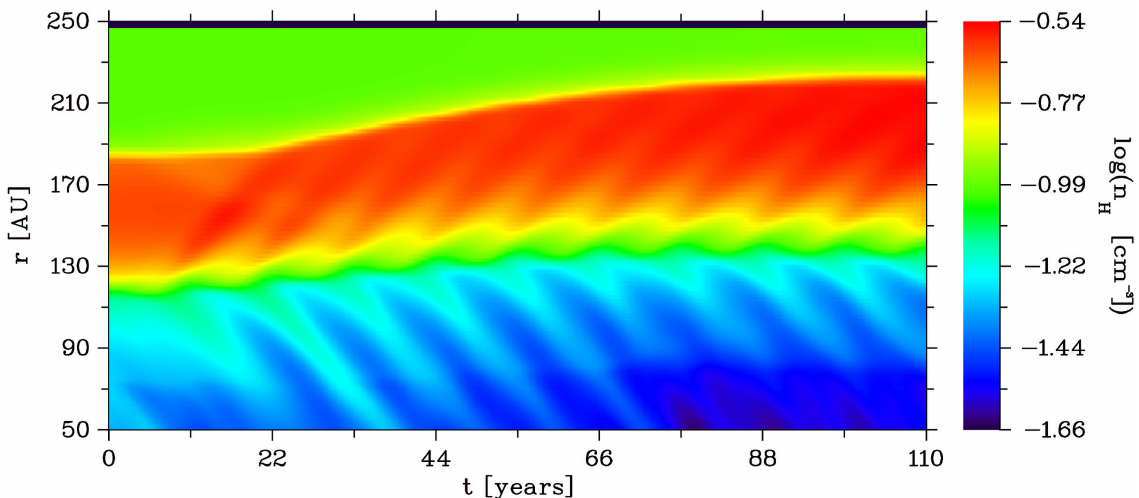
Fig. 5. The variation of the hydrogen density along the stagnation axis for almost 11 solar